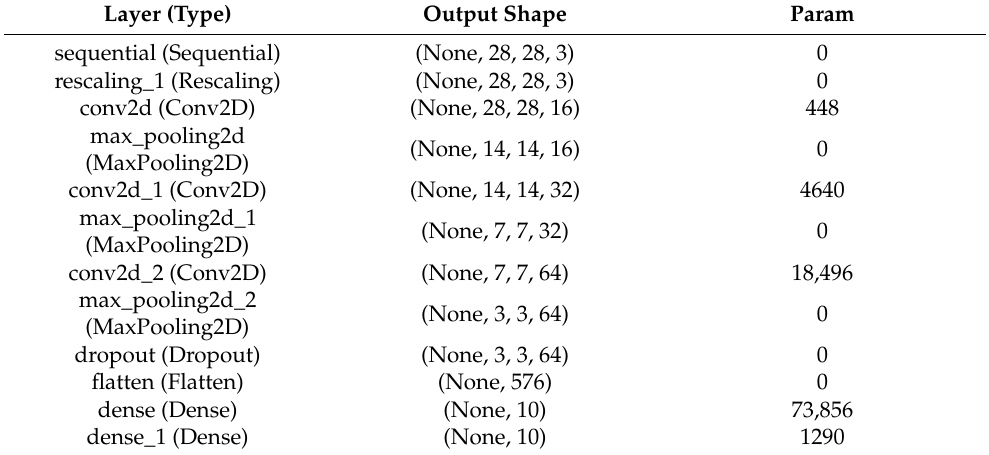
Table 1. The structure and parameters of the convolutional neural network designed in this